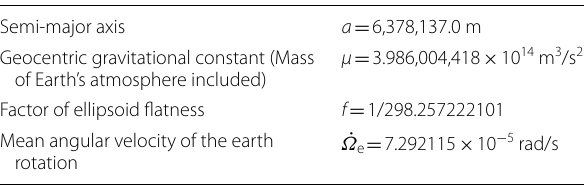
6,378,137.0 m = μ 3.986,004,418 10 14 m 3 /s 2 = × 1/298.257222101 =